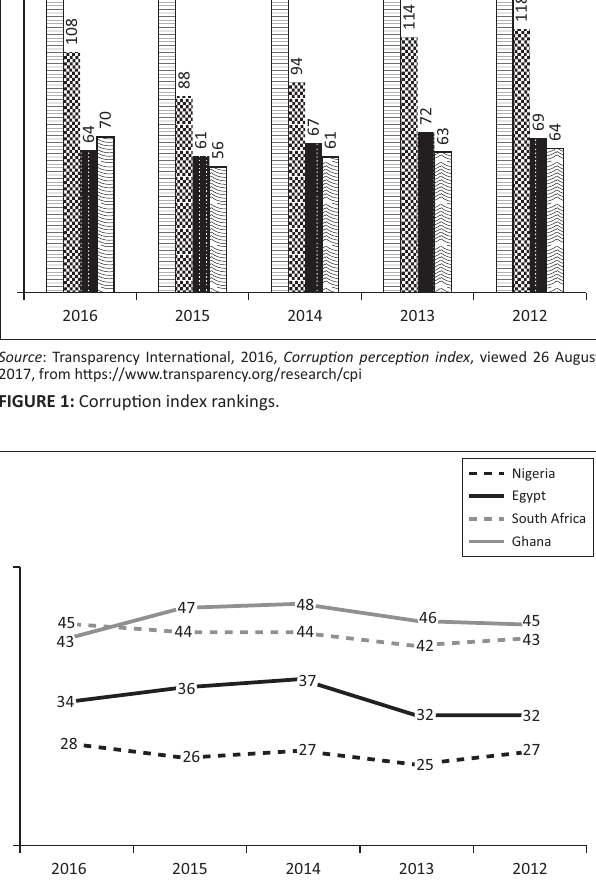
FIGURE 2: Corruption index scores.